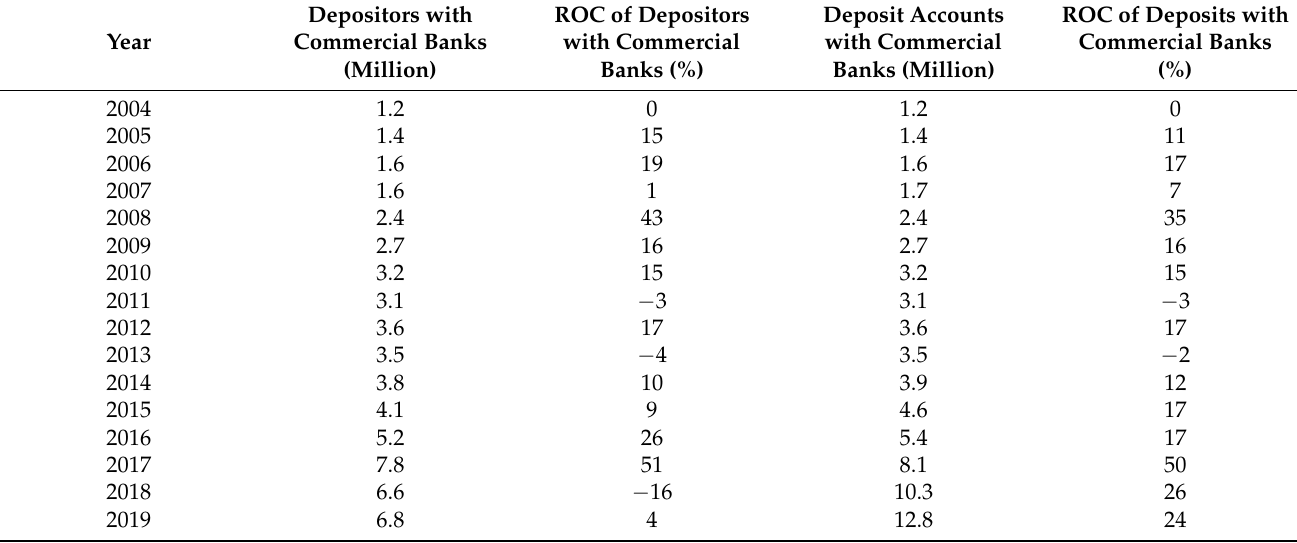
Table 2. Trends in depositors and deposit accounts with commercial banks.